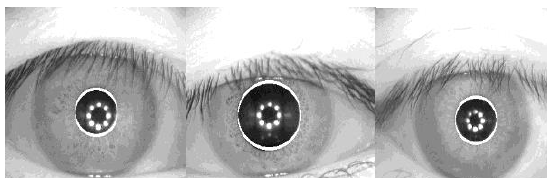
Figure 3. Iris inner boundary localized for three eye